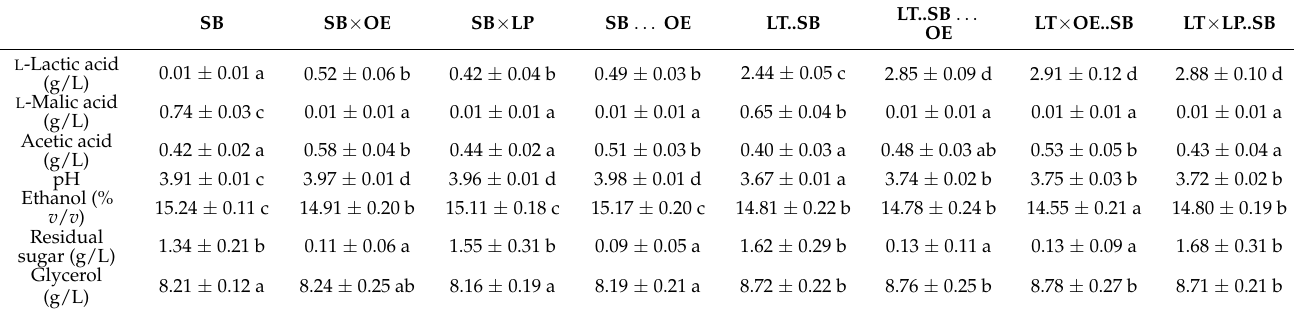
Table 2. Final chemical analysis of fermentations from Tempranillo red grapes: S. bayanus alone (SB); coinoculation of S. bayanus and O. oeni (SB × OE); coinoculation of S. bayanus and L. plantarum (SB × LP); sequential fermentation with S. bayanus and O. oeni after alcoholic fermentation (SB . . . OE); sequential fermentation with S. bayanus and L. thermotolerans during alcoholic fermentation (LT..SB); sequential fermentation with S. bayanus and L. thermotolerans during alcoholic fermentation, followed by O. oeni after alcoholic fermentation (LT..SB . . . OE); coinoculation of L. thermotolerans and O. oeni, followed by S. bayanus (LT × OE..SB); and coinoculation of L. thermotolerans and L. plantarum, followed by S. bayanus (LT × LP..SB). The initial studied characteristics of the must before alcoholic fermentation were: sugar concentration 260 g/L, pH = 3.88, primary amino nitrogen = 256 mg/L, ammonia nitrogen = 21 mg/L, malic acid = 0.86 g/L, and lactic and acetic acid were below 0.1 g/L. SB SB × OE SB × LP SB ... OE LT..SB LT..SB ... OE LT × OE..SB LT ×